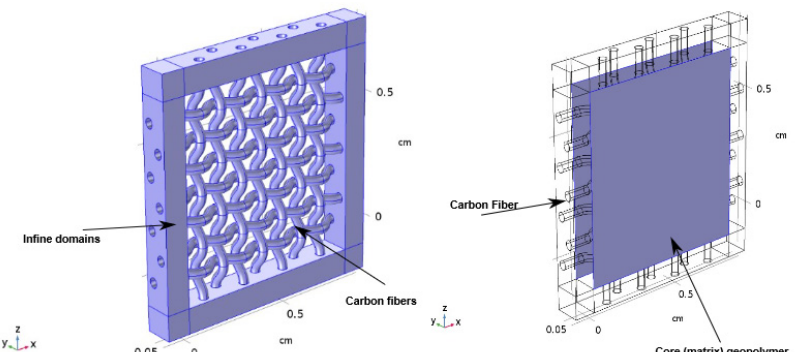
Figure 1. Model geometry of carbon fibers reinforced in geopolymer matrix with infinite element domain on the left side (highlight fiber, matrix hidden) and right side (matrix highlight, fiber hidden).